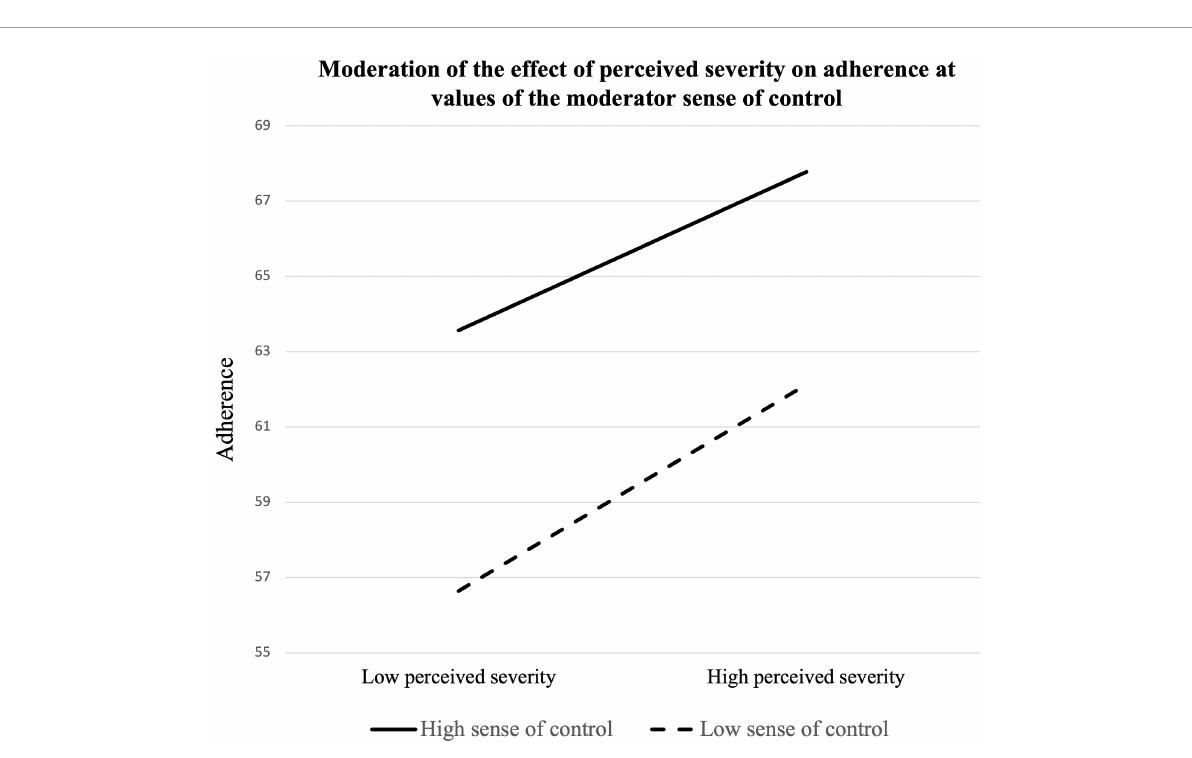
FIGURE2 Moderation of the effect of perceived severity on adherence at values of the moderator sense of